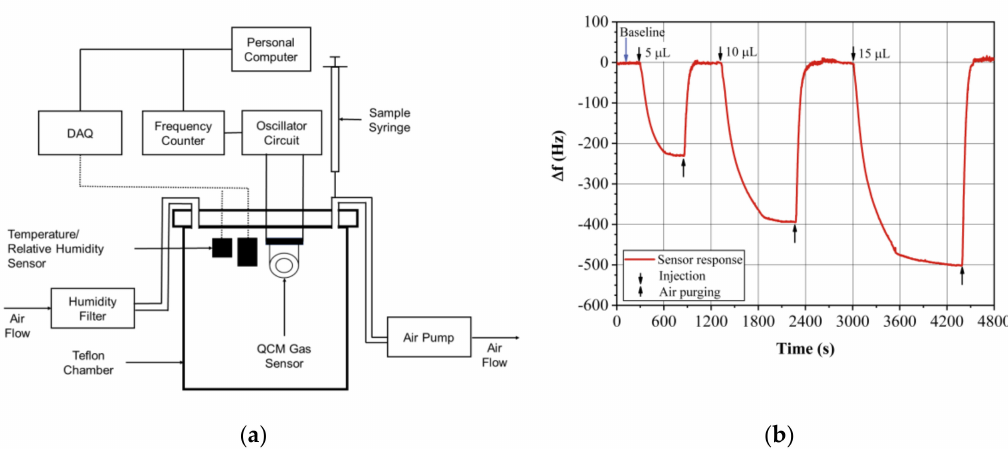
Figure 1. ( a ) Static set-up for measuring quartz crystal microbalance (QCM) gas sensors responses, ( b ) typical response curve of the QCM sensors, for this case a 30 MHz, AT-cut QCM coated with ethyl cellulose (EC) sensing film, and its response to